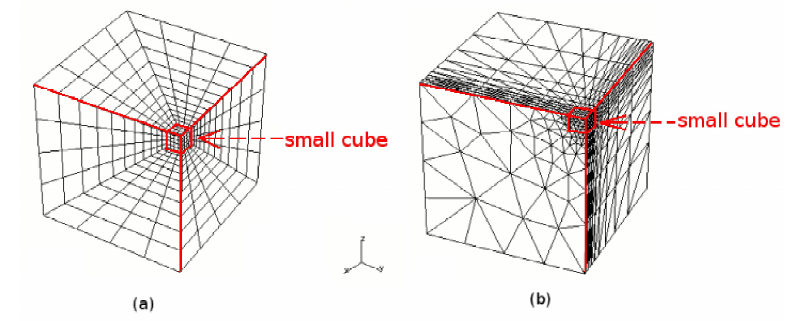
Figure 4. Meshes generated by SEPRAN: (a) hexahedron Mesh1. (b) prismatic Mesh2 (where diagonal edges on top and right surfaces are a plotting